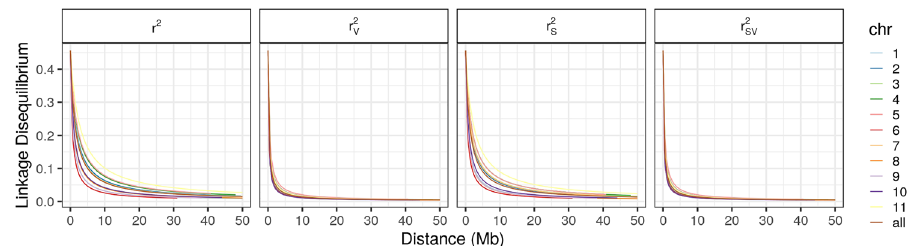
Figure 6. Analysis of linkage disequilibrium (LD) decay as a function of physical distance without correction ( r 2 ), and after correcting for population structure ( r 2 s ), relatedness ( r 2 v ), and for both population structure and relatedness ( r 2 vs ). Figure produced in R